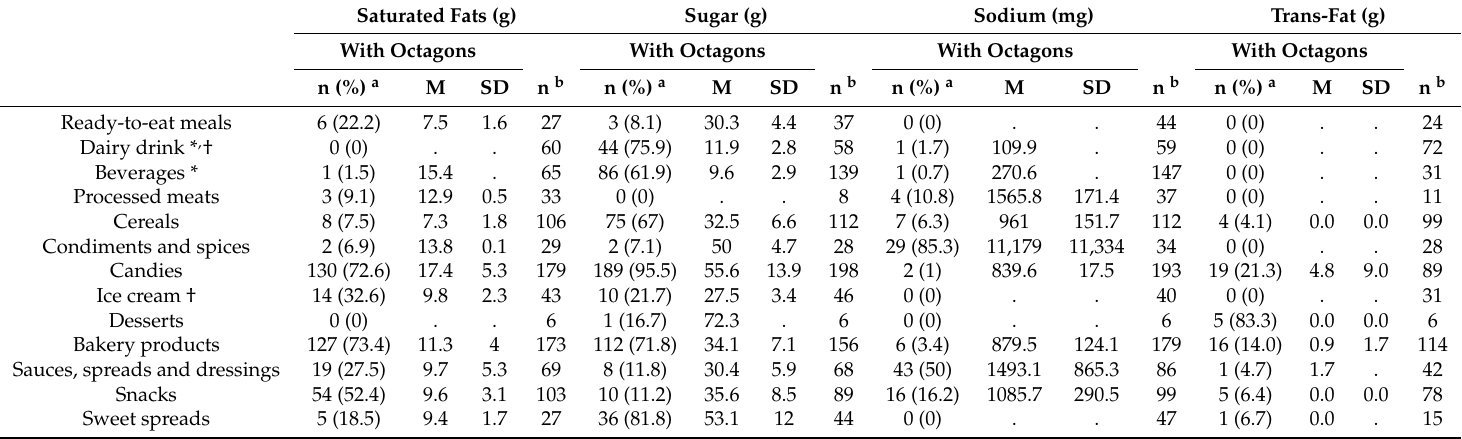
Table 3. Percentage of foods by category that would carry front-of-package warning labels 6 months after implementation of the Law.